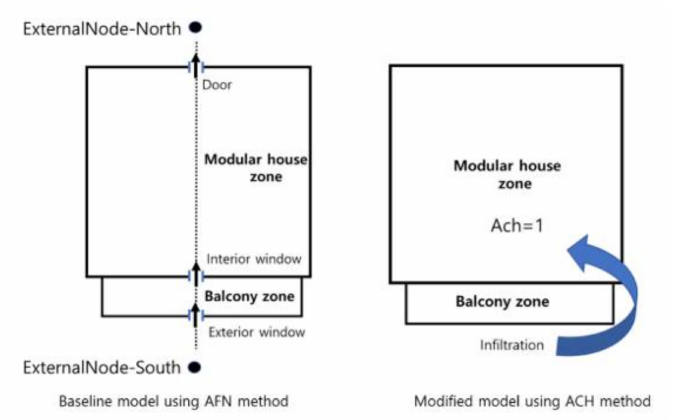
Figure 4. Air movement route in the AFN model and in ACH